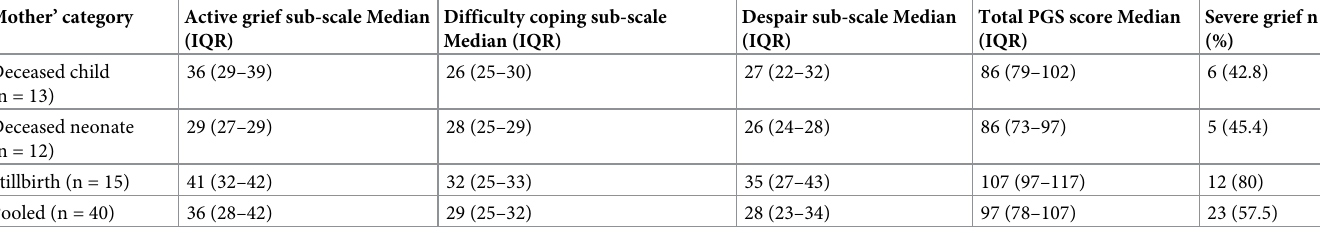
Table 2. Mother’s grief status after 6–9 months of the event by Perinatal Grief Scale (PGS). Mother’